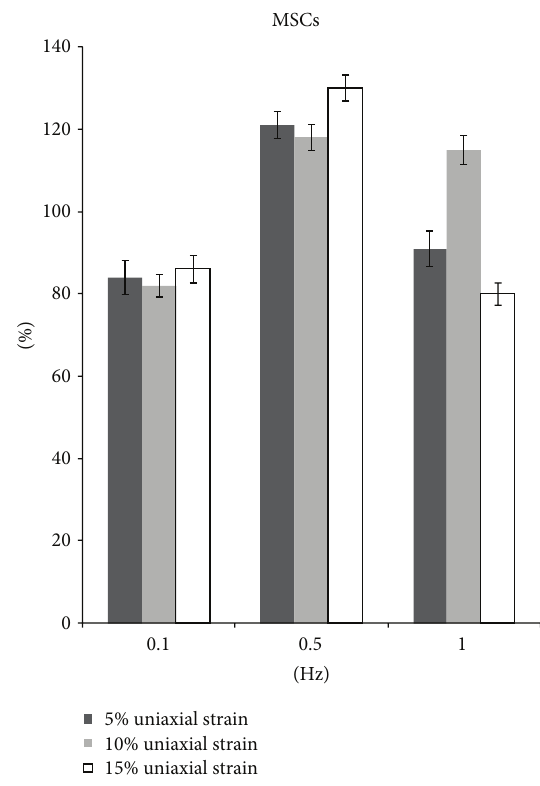
Figure 6: The collagen production of MSCs after uniaxial stretch